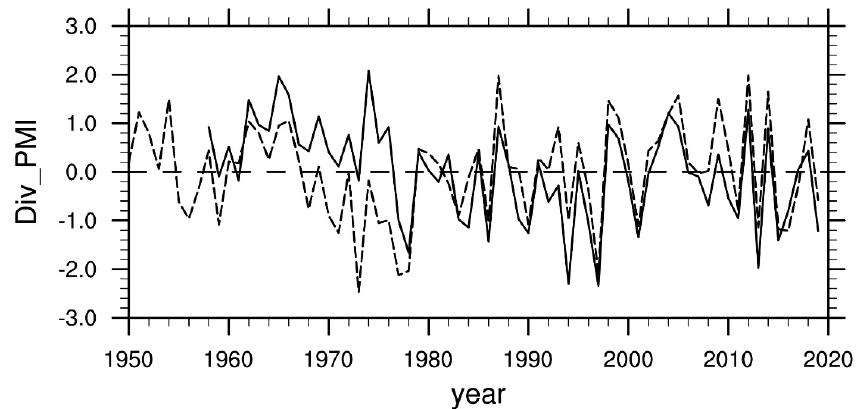
Figure 9. Standardized time series of the summer monsoon index on the TP, the black solid line is the JRA-55 reanalysis data result, and the black dashed line is the ERA5 reanalysis data